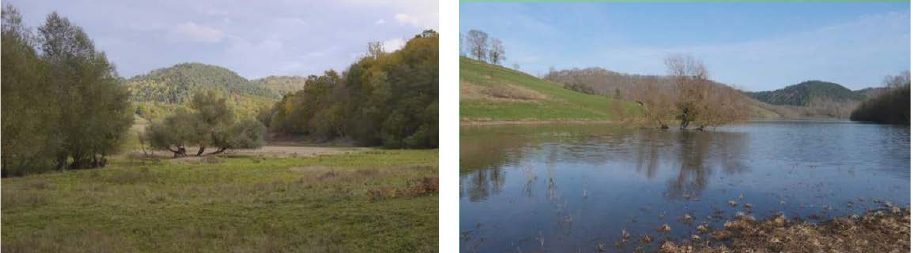
Figure 3. Emerged ( left panel) and submerged part ( right panel) of the study site showing the extent of the desiccated area between June and August.